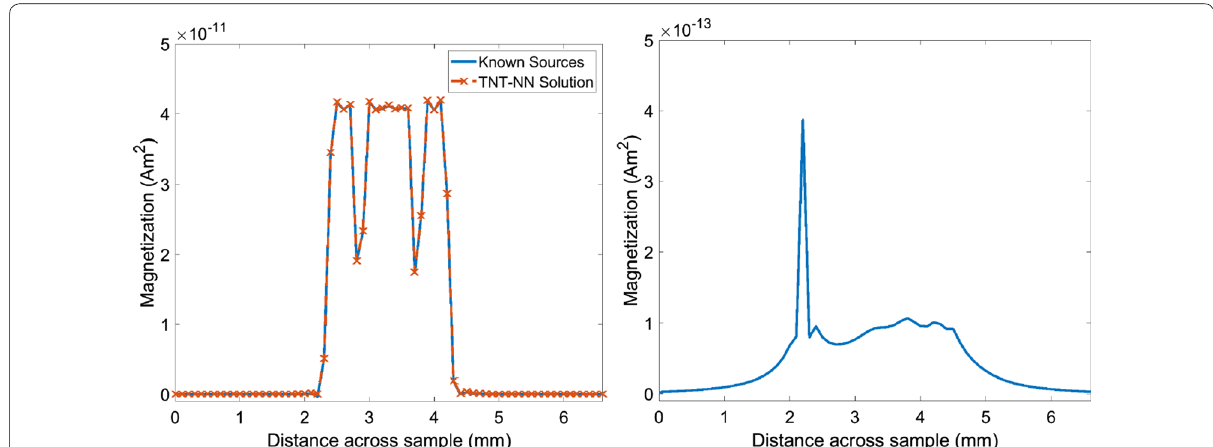
Fig. 12 Horizontal transects through the center of the synthetic UMN logo results for scenario 3. Shown at left are the TNT-NN solution and known solution and at right is the difference thereof. Without additional regularization, least-squares methods act as low-pass filters which produce solutions that are naturally smooth. This can manifest as a “spreading” of the solution in space as seen at the right. This behavior does not allow the least-squares solution to fully capture the sharp interfaces in the known